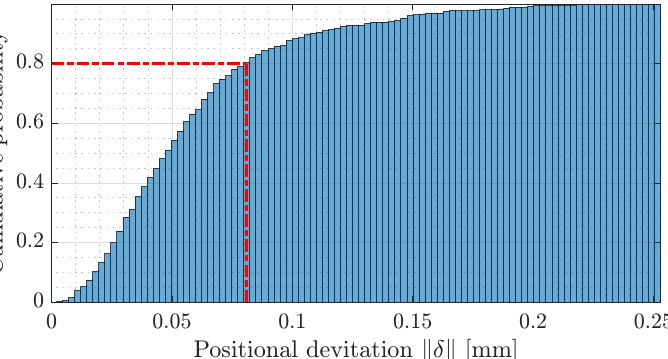
Figure 9. Cumulative histogram of the positional deviations δ post-calibration. As illustrated by the red line, note that 80% of the positional deviations are below 0.08 mm. The remaining 20% of the positional deviations are located at the border of the calibration